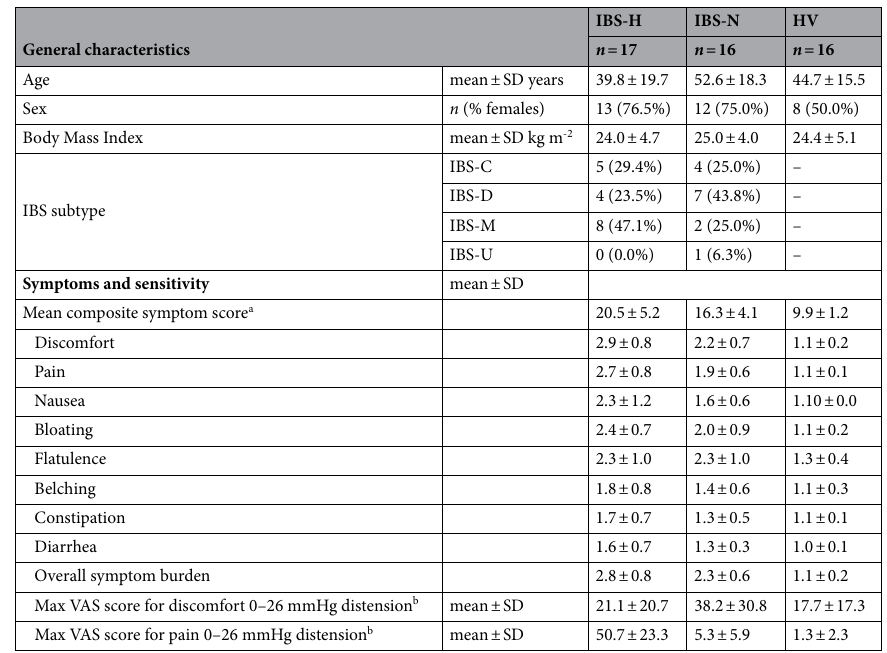
Table 2. Patient characteristics for fungal genetic and phenotype analysis. Patients recruited from Maastricht IBS (MIBS) study cohort. a Composite score calculated based on 14-day mean of 9 subjects scored on a 5-point Likert scale. Each subject was scored from 1 to 5 (i.e. abdominal discomfort, abdominal pain, nausea, bloating, flatulence, belching, constipation, diarrhea, symptom burden). Composite score range 9–45. b Maximum VAS for pain 0–26 mmHg ≥ 20 mm is considered as hypersensitive to colorectal